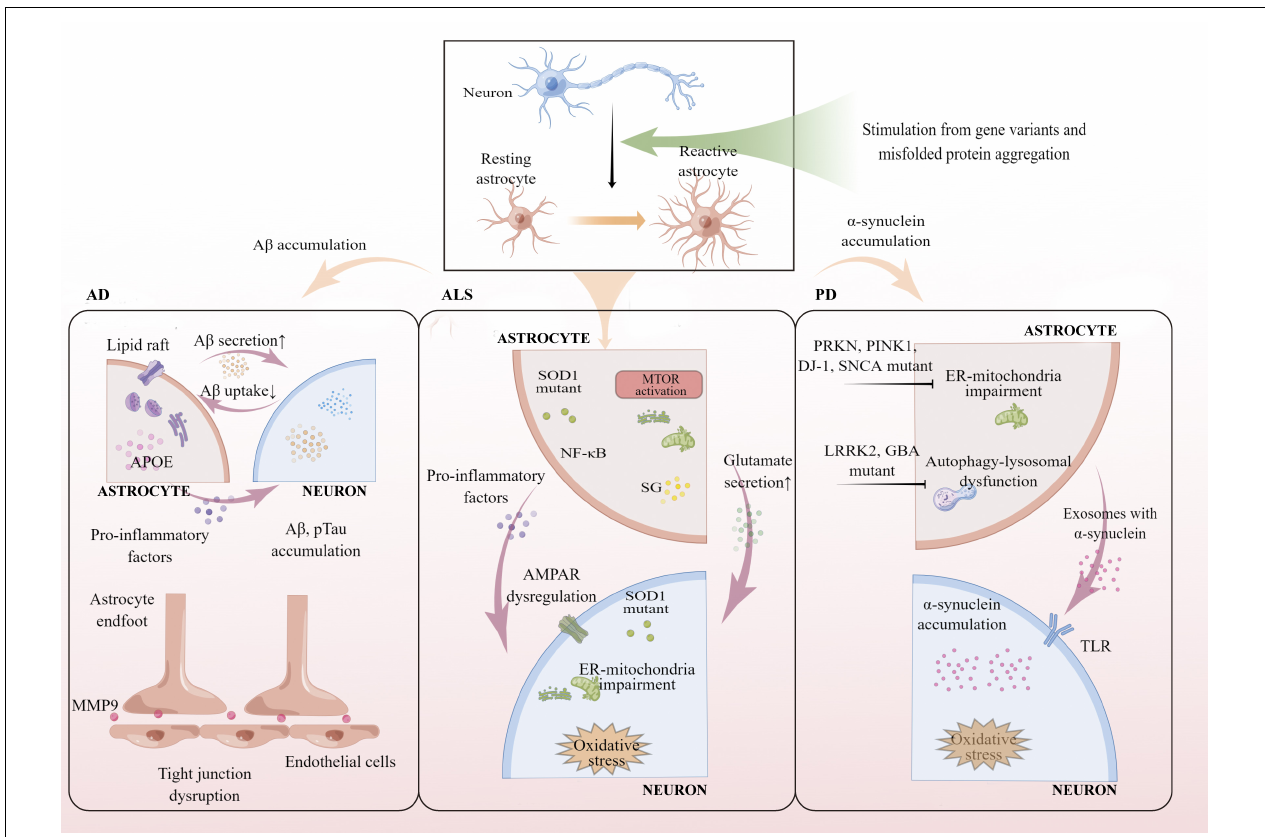
FIGURE 1 | Summary of reactive astrocytes involved in pathogenic or risk gene variants of AD, ALS, and PD. Reactive astrocytes carrying APOE ε 4 promote A β and pTau accumulation in both astrocytes and neurons. Reactive astrocytes with APOE ε 4 allele secrete pro-inflammatory factors and damage BBB integrity by upregulating MMP9. Reactive astrocytes with SOD1 mutant increase glutamate secretion and hyperexcitability by dysregulated AMPAR, resulting in ER-mitochondrial impairment and oxidative stress in MNs. α -synuclein accumulation and oxidative stress increase in neurons through damaged ER-mitochondria in reactive astrocytes with PRKN , PINK1 , DJ-1 , SNCA mutant, and autophagy-lysosomal dysfunctions were found in reactive astrocytes with LRRK2 , GBA mutant. AD, Alzheimer’s disease; ALS, amyotrophic lateral sclerosis; PD, Parkinson’s disease; APOE , apolipoprotein E; SOD1 , Cu/Zn-superoxide dismutase 1 gene; LRRK2 , Leucine-rich repeat kinase 2 gene; SNCA , α -synuclein gene; PRKN , parkin gene; PINK1 , PTEN-induced putative kinase 1 gene; GBA , glucocerebrosidase gene; MMP9, matrix metalloproteinase 9; NF- κ B, nuclear factor-kappa B; mTOR, mammalian target of rapamycin pathway; SG, stress granules; AMPAR, α -amino-3-hydroxy-5-methyl-4-isoxazole-propionic acid receptor; ER, endoplasmic reticulum; TLR, Toll-like